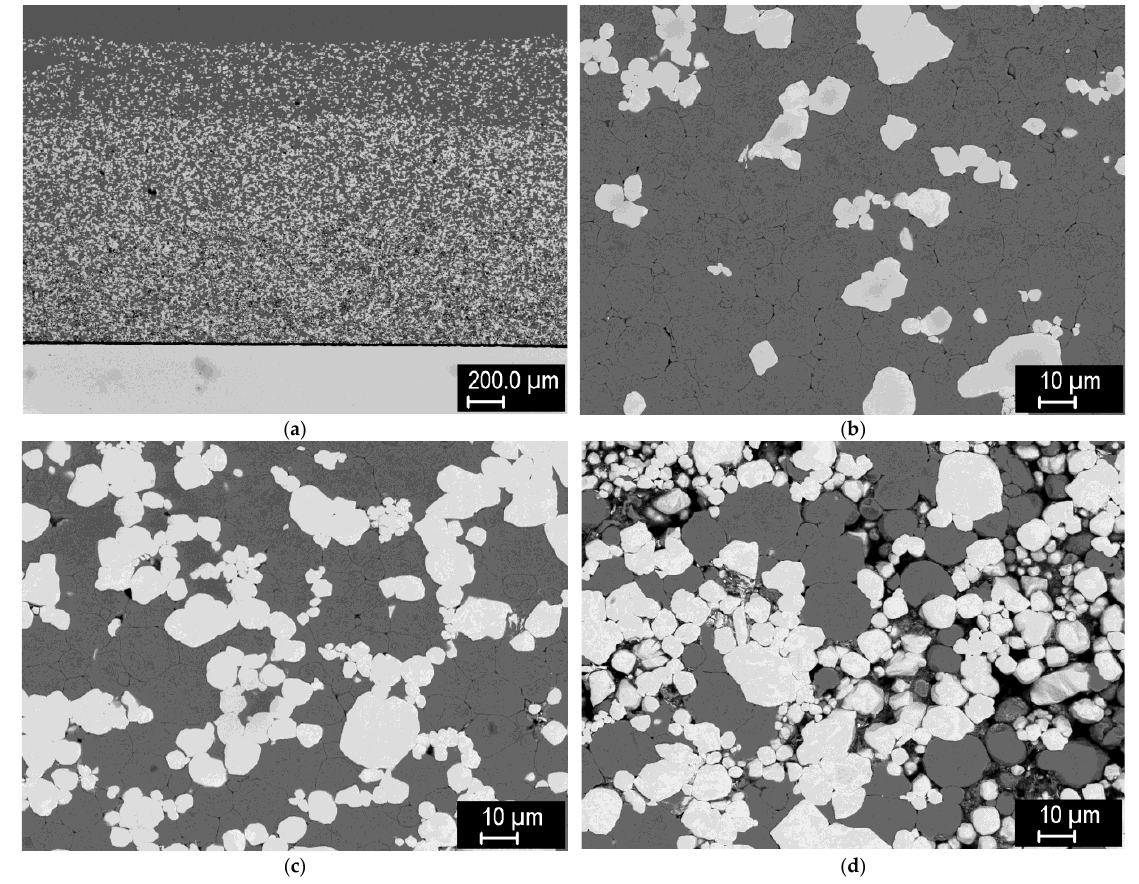
Figure 16. Tungsten pellet with a 4-layer FGM, sintered at 1000 °C. ( a ) overview; ( b ) detail of 20/80 layer; ( c ) detail of 40/60 layer; ( d ) detail of 60/40 layer.